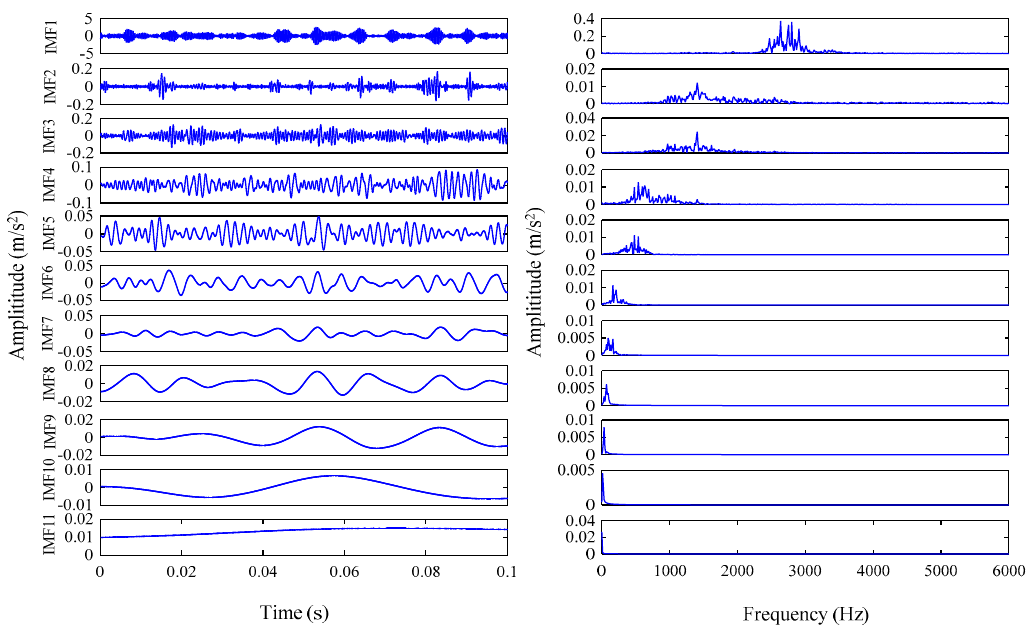
Figure 19. Decomposition results and corresponding frequency spectrum of IMFs for outer ring defect with EEMD.